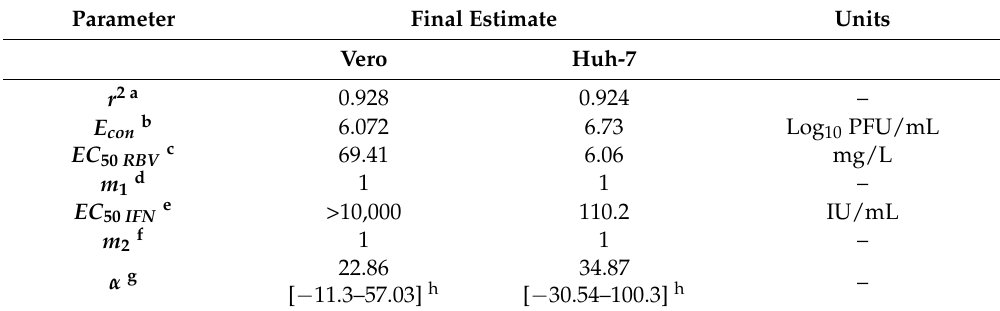
Figure 1. Antiviral activity of ribavirin (RBV) and interferon- α (IFN) as a combination therapy against DENV2. ( A ) Vero cells were infected at a multiplicity of infection of 0.001 PFU/cell and exposed to RBV and/or IFN. Viral supernatants were collected on day 3; ( B ) Huh-7 cells were infected at a multiplicity of infection of 0.01 PFU/cell and exposed to RBV and/or IFN. Supernatant samples were harvested after two days post-infection. Viral burden was quantified by plaque assay in Vero cells and reported as log 10 PFU/mL. Data points correspond to the geometric mean of three independent samples and error bars represent one standard deviation. Horizontal dashed lines represent the assay limit of detection. Table 3. Mean estimate parameter values from ribavirin (RBV) and interferon- α (IFN) combination therapy.